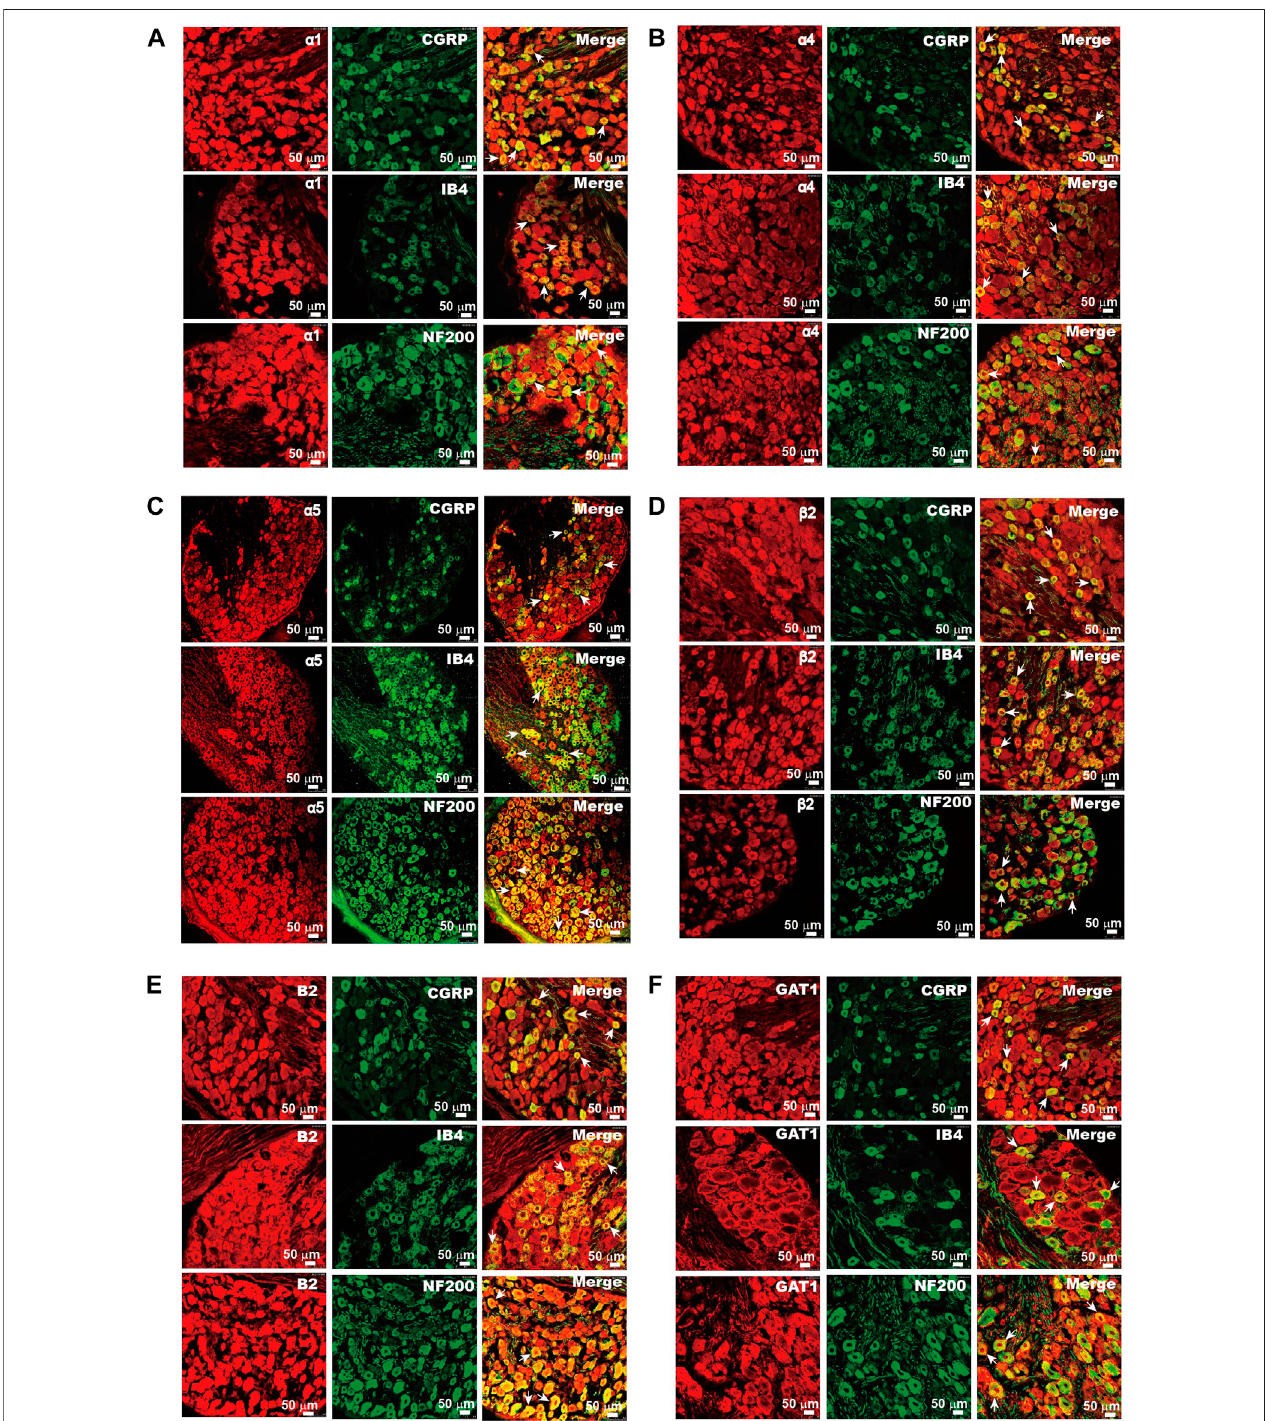
FIGURE 1 | Expression of GABA-related proteins in DRG neurons. Immuno fl uorescent images of α 1 (A) , α 4 (B) , α 5 (C) , and β 2 (D) of the GABA A receptor, B2 subunit of the GABA B receptor (E) , and GAT1 (F) in rat DRG neurons. The co-localization of these proteins (red) and sensory neuron markers CGRP, IB4, and NF200 (green)wereanalyzed.Arrowsindicatetherepresentativeneuronswithco-localizationoftestedproteinsandsensoryneuronmarkers.Micrographswithineachpanelare of the same magni fi cation; scale bar represents 50 μ m.